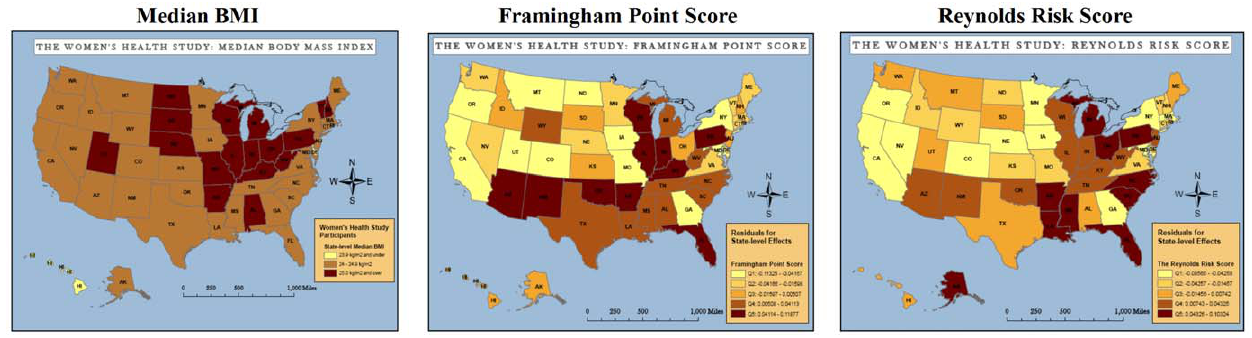
Figure 3. State-level Variation in Cardiovascular Risk Scores and State Median BMI in the Women’s Health Study. Source: Women’s Health Study Participants. Abbreviations: Q1: Lowest quintile of risk; Q5: Highest quintile of risk. Models not adjusted for covariates.